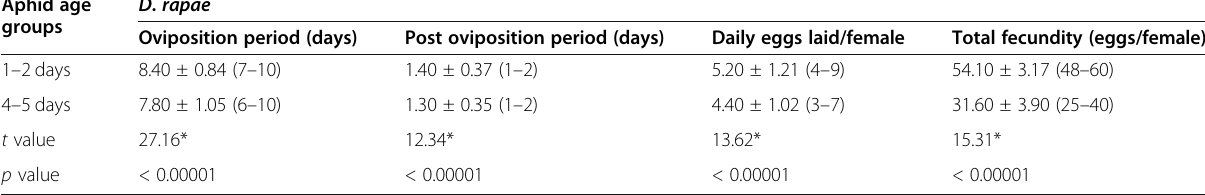
Table 9 Developmental parameters (mean ± SE) of D . rapae females parasitizing different age groups of M . persicae Aphid age groups